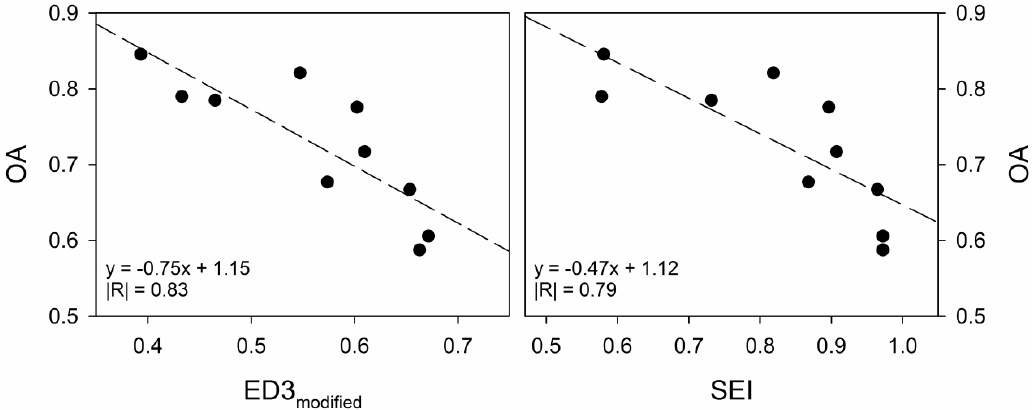
Figure 9. Classification accuracy ( i.e. , OA) vs. segmentation quality ( i.e. , ED3 Modified and SEI).